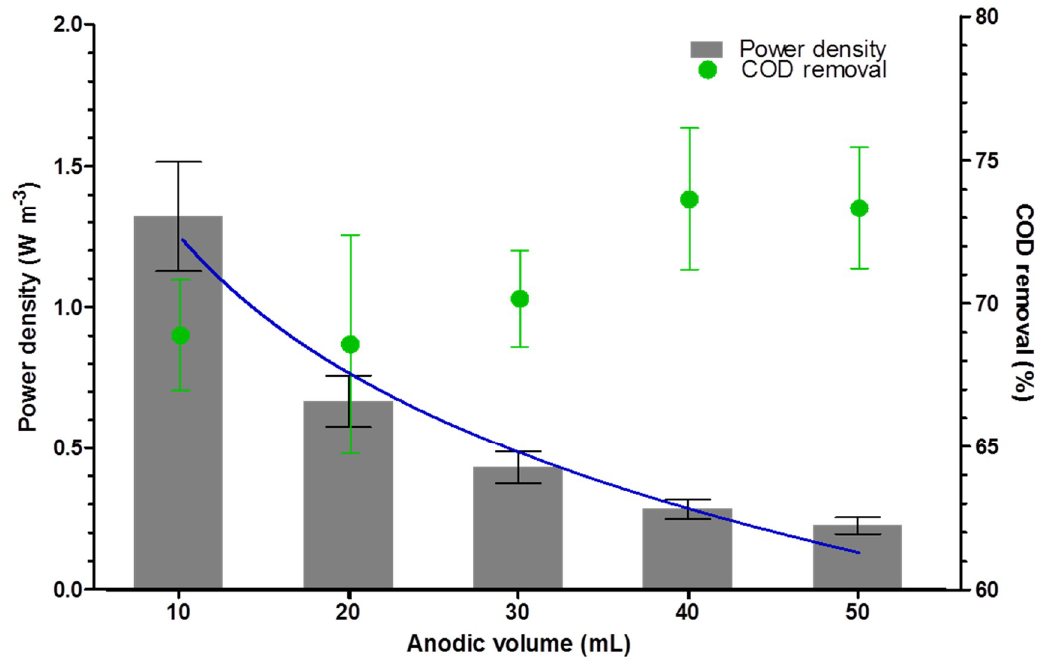
Figure 7. Volumetric power density and COD removal efficiency with different anodic volume (blue line shows the trend of volumetric power density).